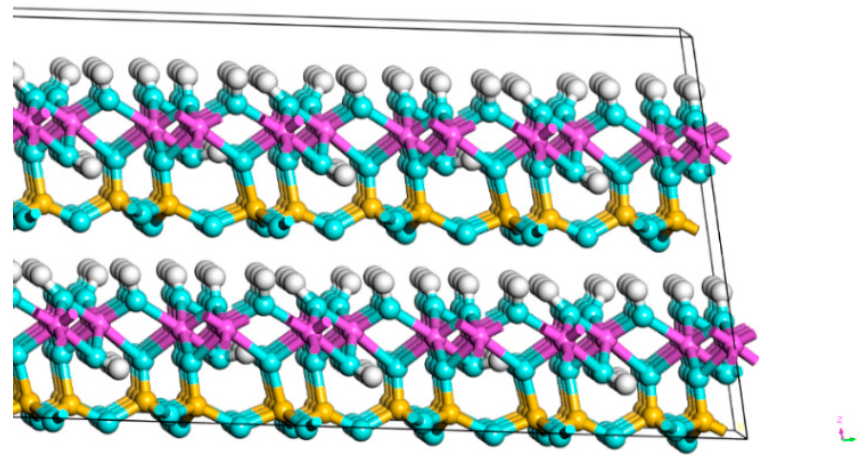
Figure 3. Ball-and-stick model of kaolinite crystal structure (white ball: H, blue ball: O, purple ball: Al, and yellow ball: Si).